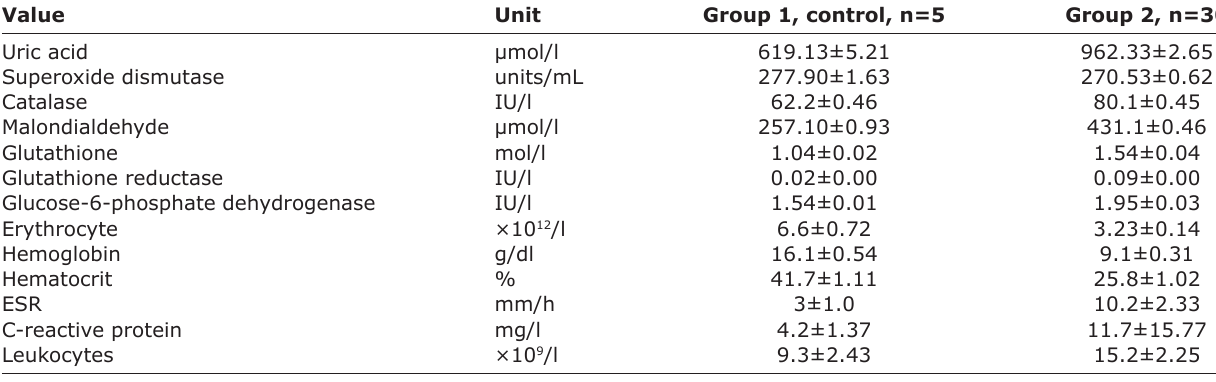
Table-2: Changes in the level of lipid peroxidation in dogs on the 1 st day of the study, M±m. Value Unit Uric